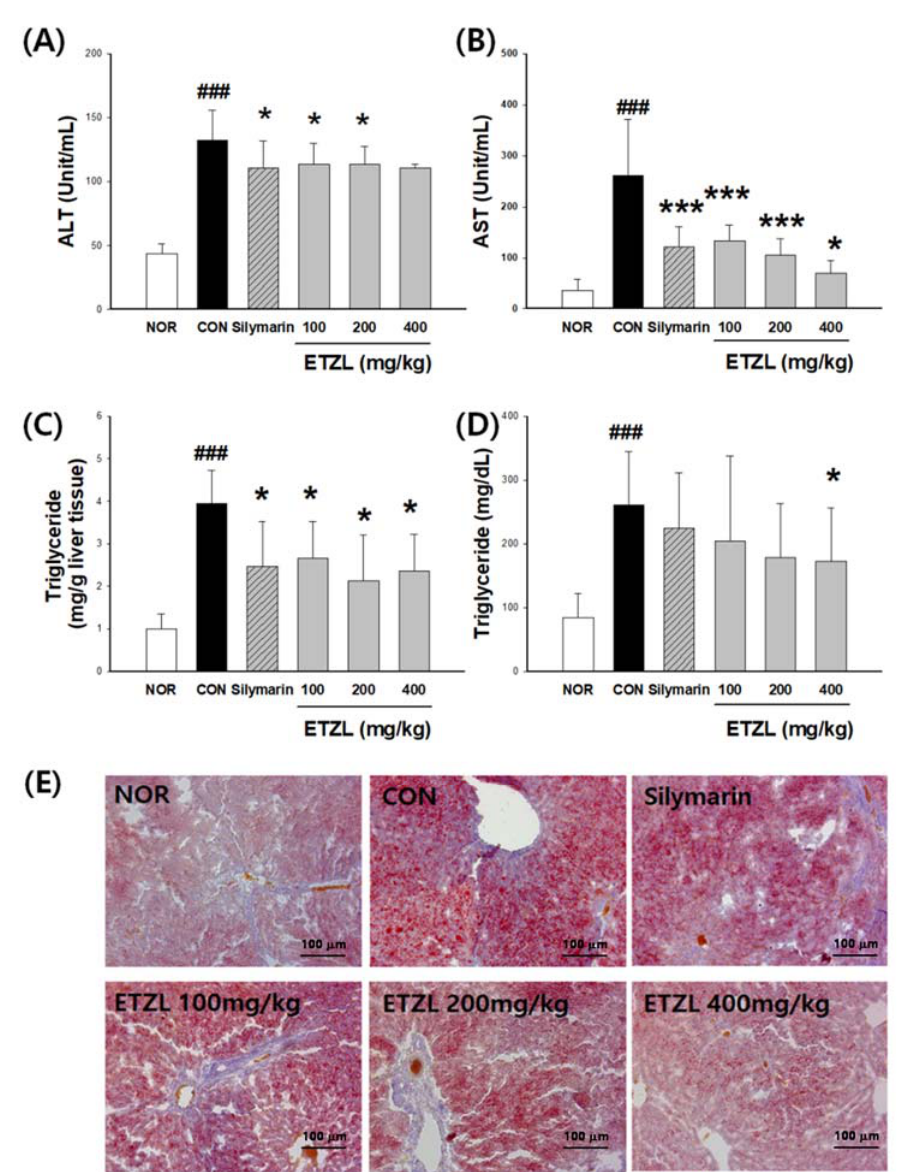
Figure 3. Effects of ETZL treatment on hepatic steatosis in binge rats. SD rats (male, 7 weeks, n = 10 rats per group) were used. Rats in the alcohol group were administered 5 g/kg alcohol intragastrically every 12 h for a total of 3 doses. ETZL was orally administered at 100, 200, or 400 mg/kg, 30 min before alcohol administration. Control animals received an identical volume of the vehicle. The positive control was gavaged with silymarin (50 mg/kg). Serum levels of ( A ) ALT, ( B ) AST, ( C ) hepatic triglyceride (TG), ( D ) serum triglyceride (TG), and ( E ) Oil Red O staining of liver sections of rats with ETZL. Values are expressed as mean ± SD. Significant differences compared with the normal (NOR) are indicated by ### p < 0.001. Significant differences compared with the control (CON) are indicated by * p < 0.05 and *** p < 0.001.